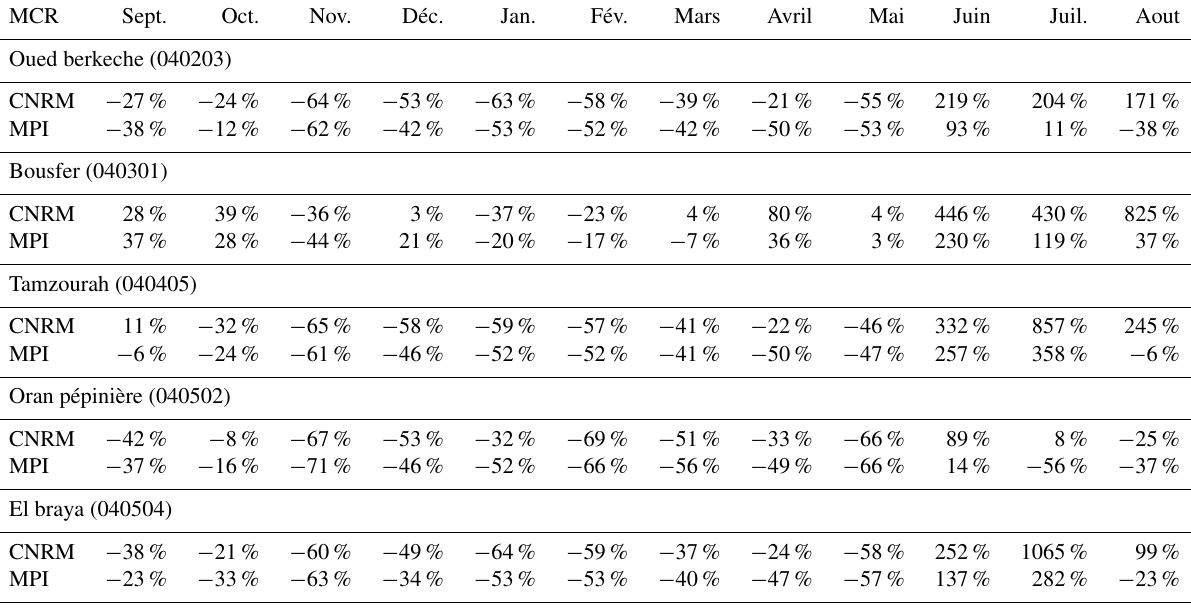
Tableau 2. Biais estimé entre les pluies observées et simulées au cours de la période de référence 1981–2005. MCR Sept.